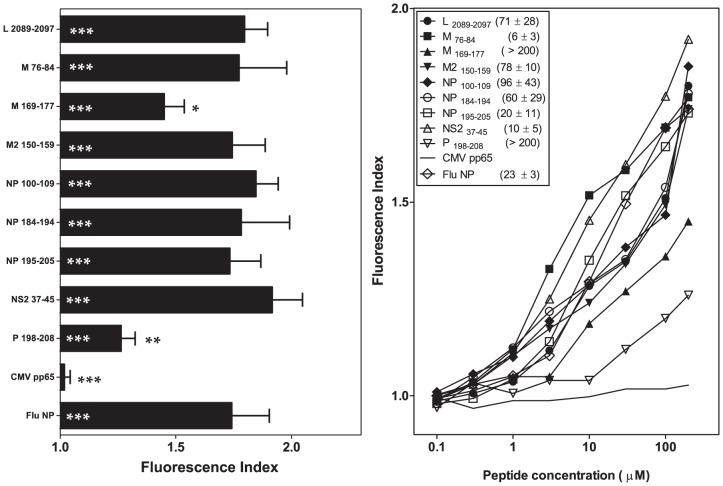
HLA-B*2703 stabilization with synthetic HRSV ligands.The stability of HLA-B*2703/peptide complexes on the cell surface of transfected RMA-S cells was measured using flow cytometry. The results shown in left and right panels are depicted as in Fig. 1A and 2B, respectively, showing the mean values obtained from three or four independent experiments.